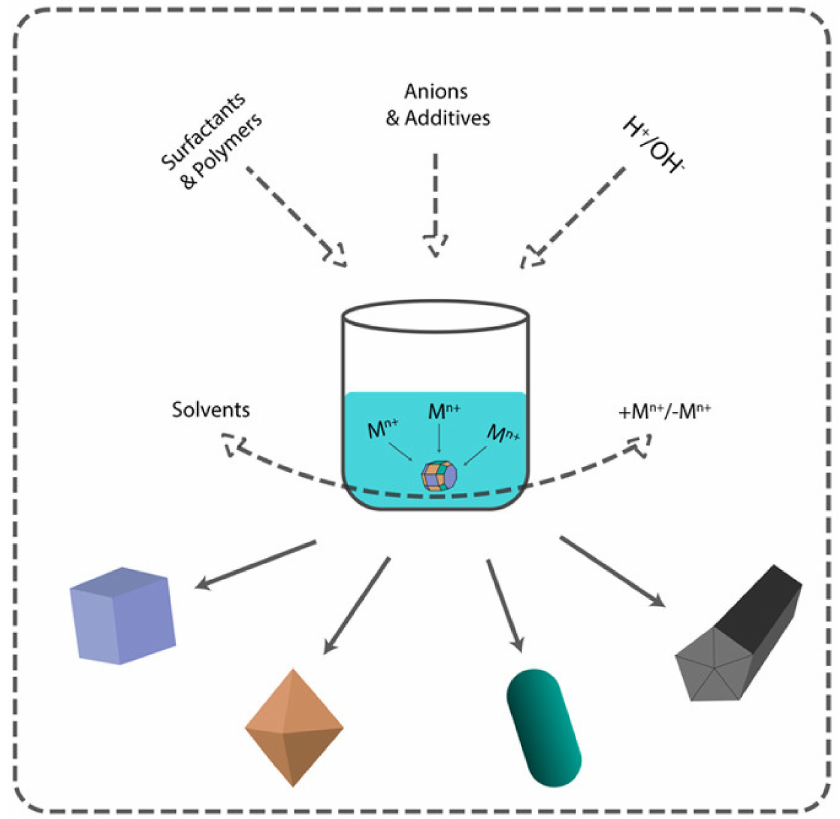
Figure 2. Main approaches for nanomaterial shape